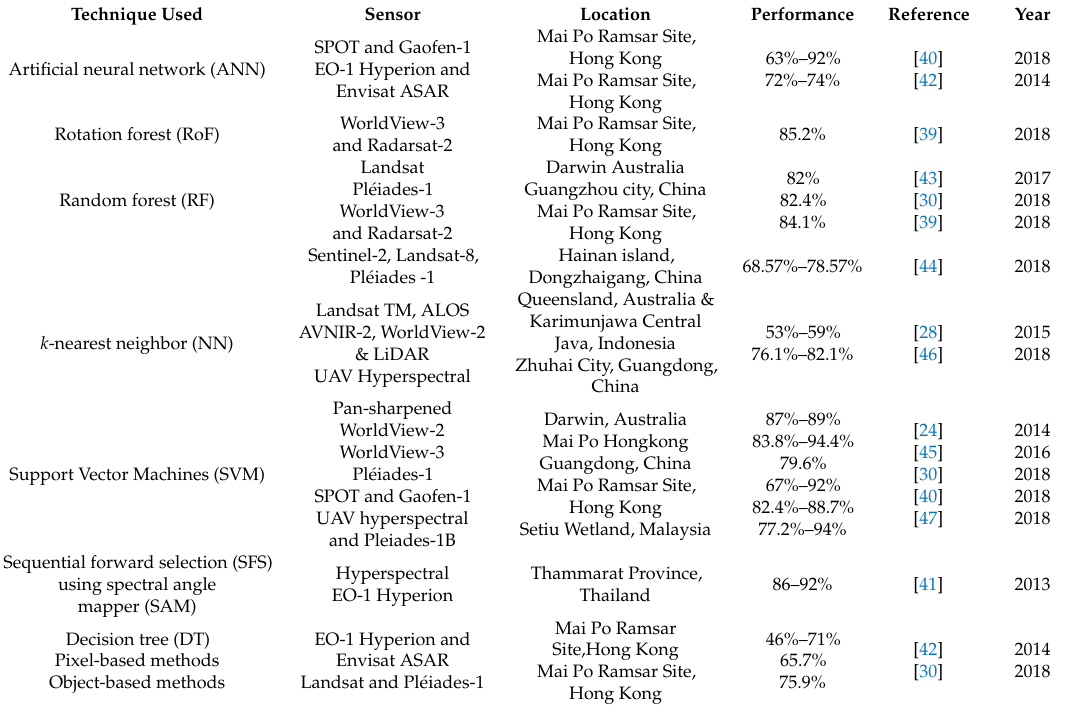
Table 2. Machine learning approaches to discriminate mangrove